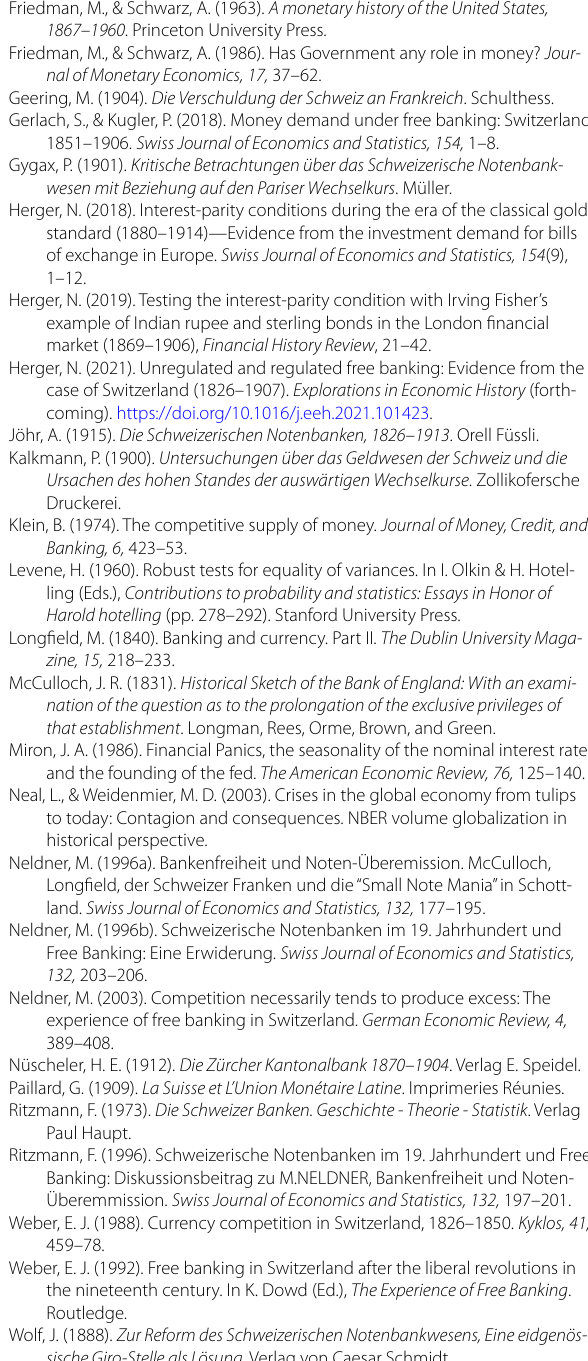
Table 5 Analysis of variance (ANOVA) of the discount-rate